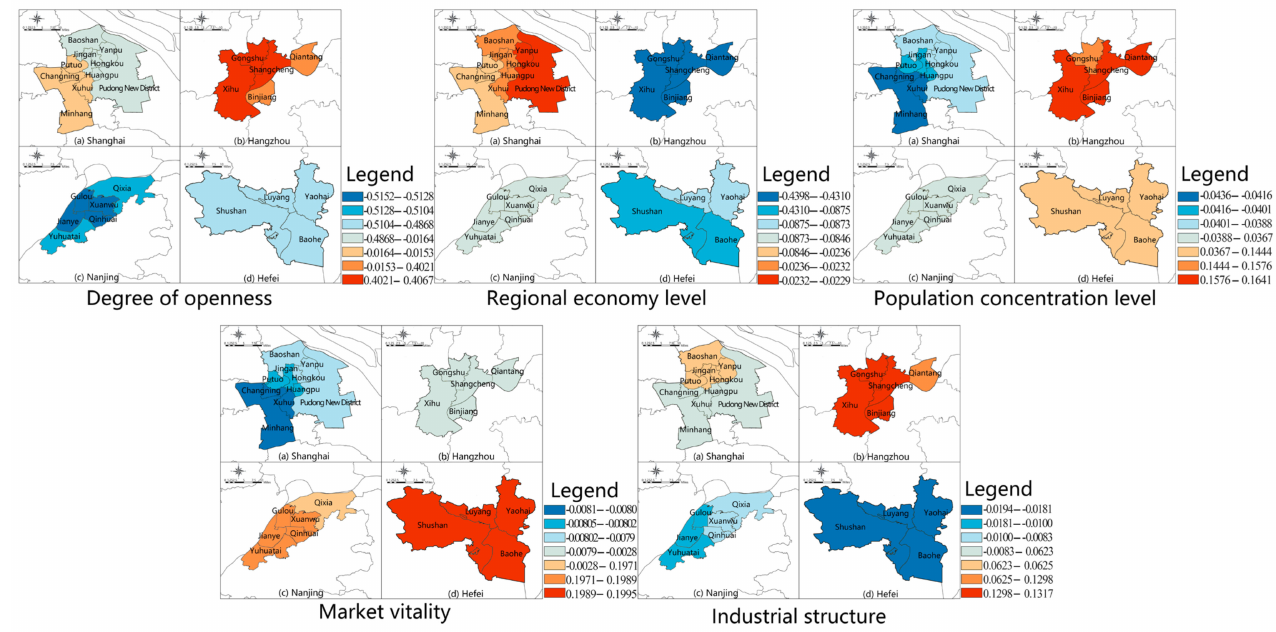
Figure 14. Spatial distribution of regression coefficients of GWR model of CLI in